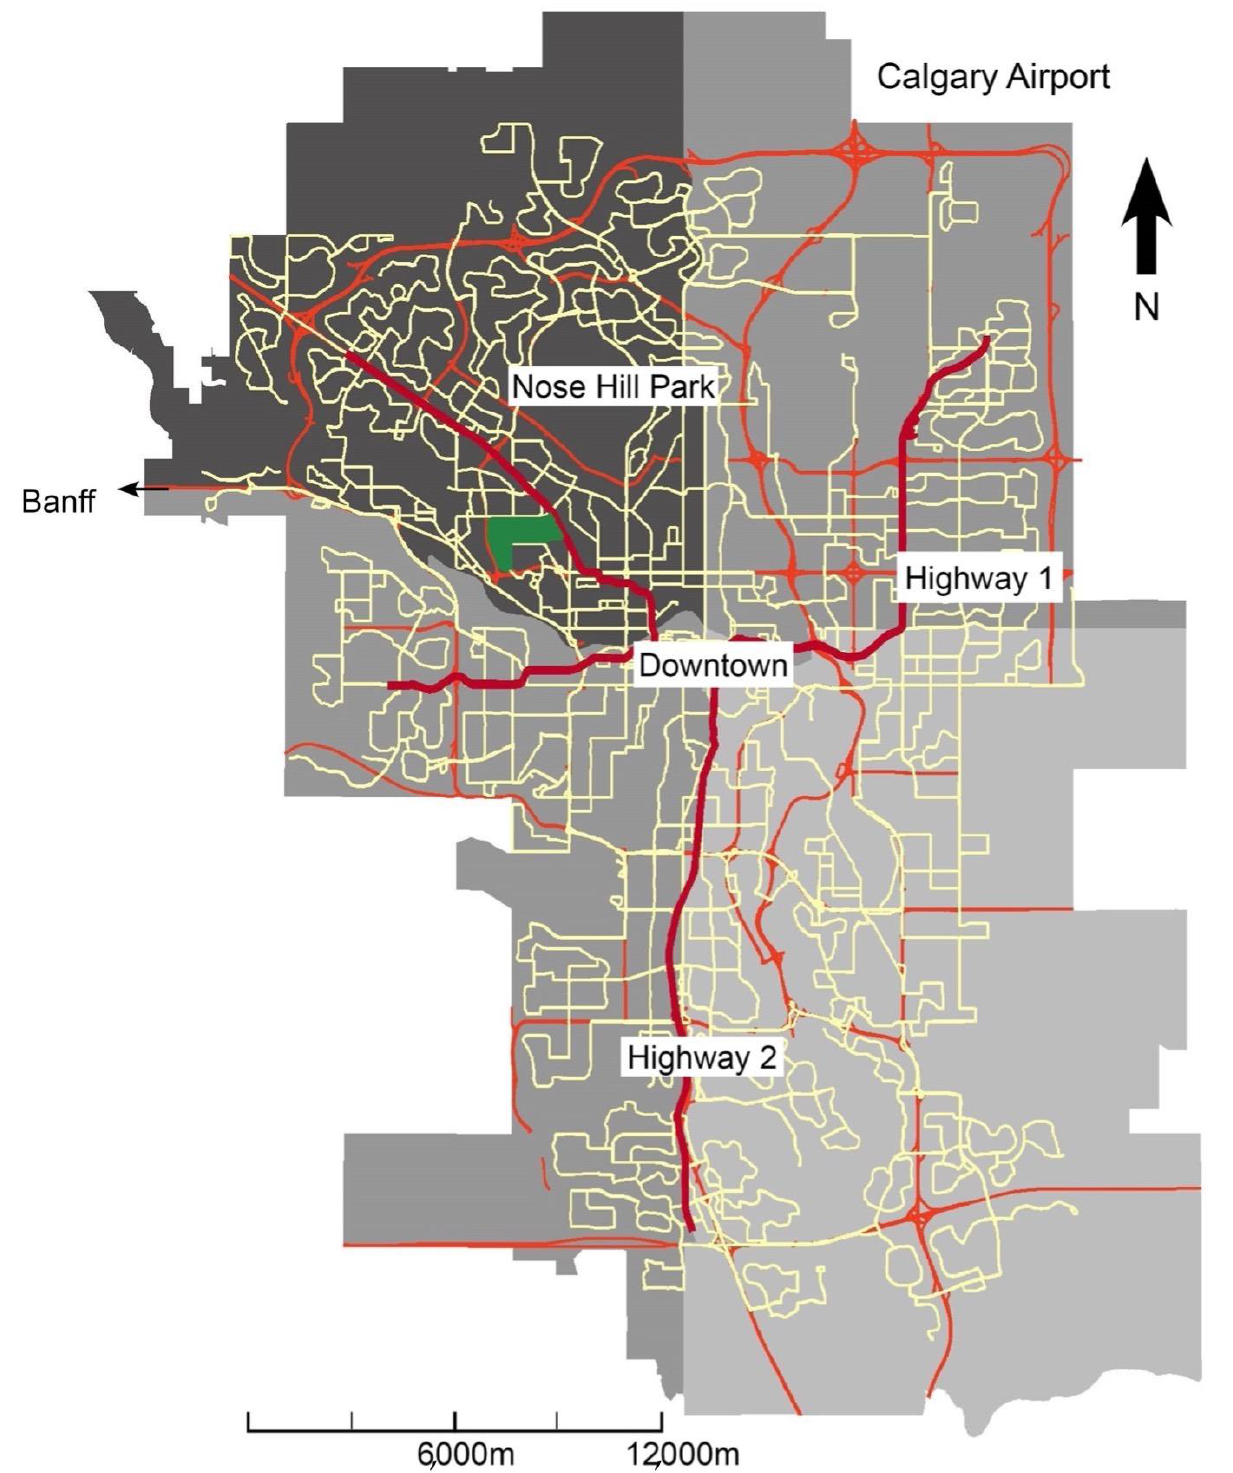
Figure 1. Map of study area. University of Calgary campus location can be seen in green. Transport infrastructure, visible on the map includes bus routes (yellow), LRT line (bold red) and highways (red). Different quadrants are defined by varying shadings (grey).